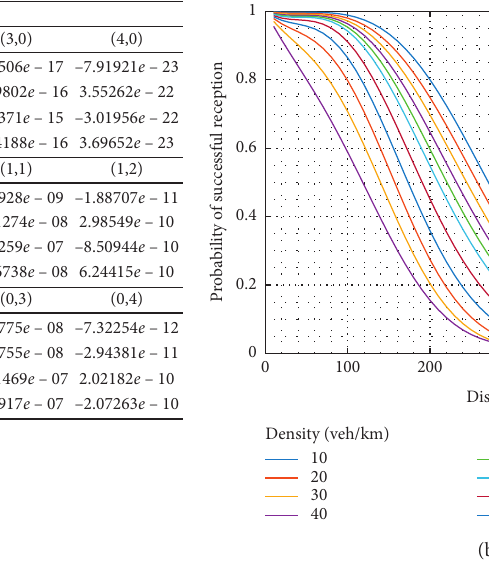
Figure 14: DSRC model coefficients and PDF. (a) Coefficient h ( j,k ) i in equation (4). (b) PDF of successful reception (300 m power